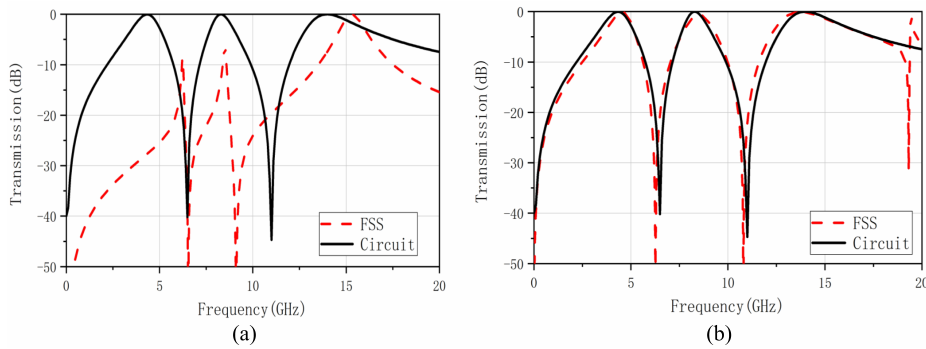
Figure 7. ( a ) Transmission coefficient of triple band − pass FSS for the ECM (shown in red) and desired (shown in black), ( b ) Transmission coefficient of optimized triple band − pass FSS for the optimized structure parameters by MOPSO algorithm (shown in red) and desired (shown in black).